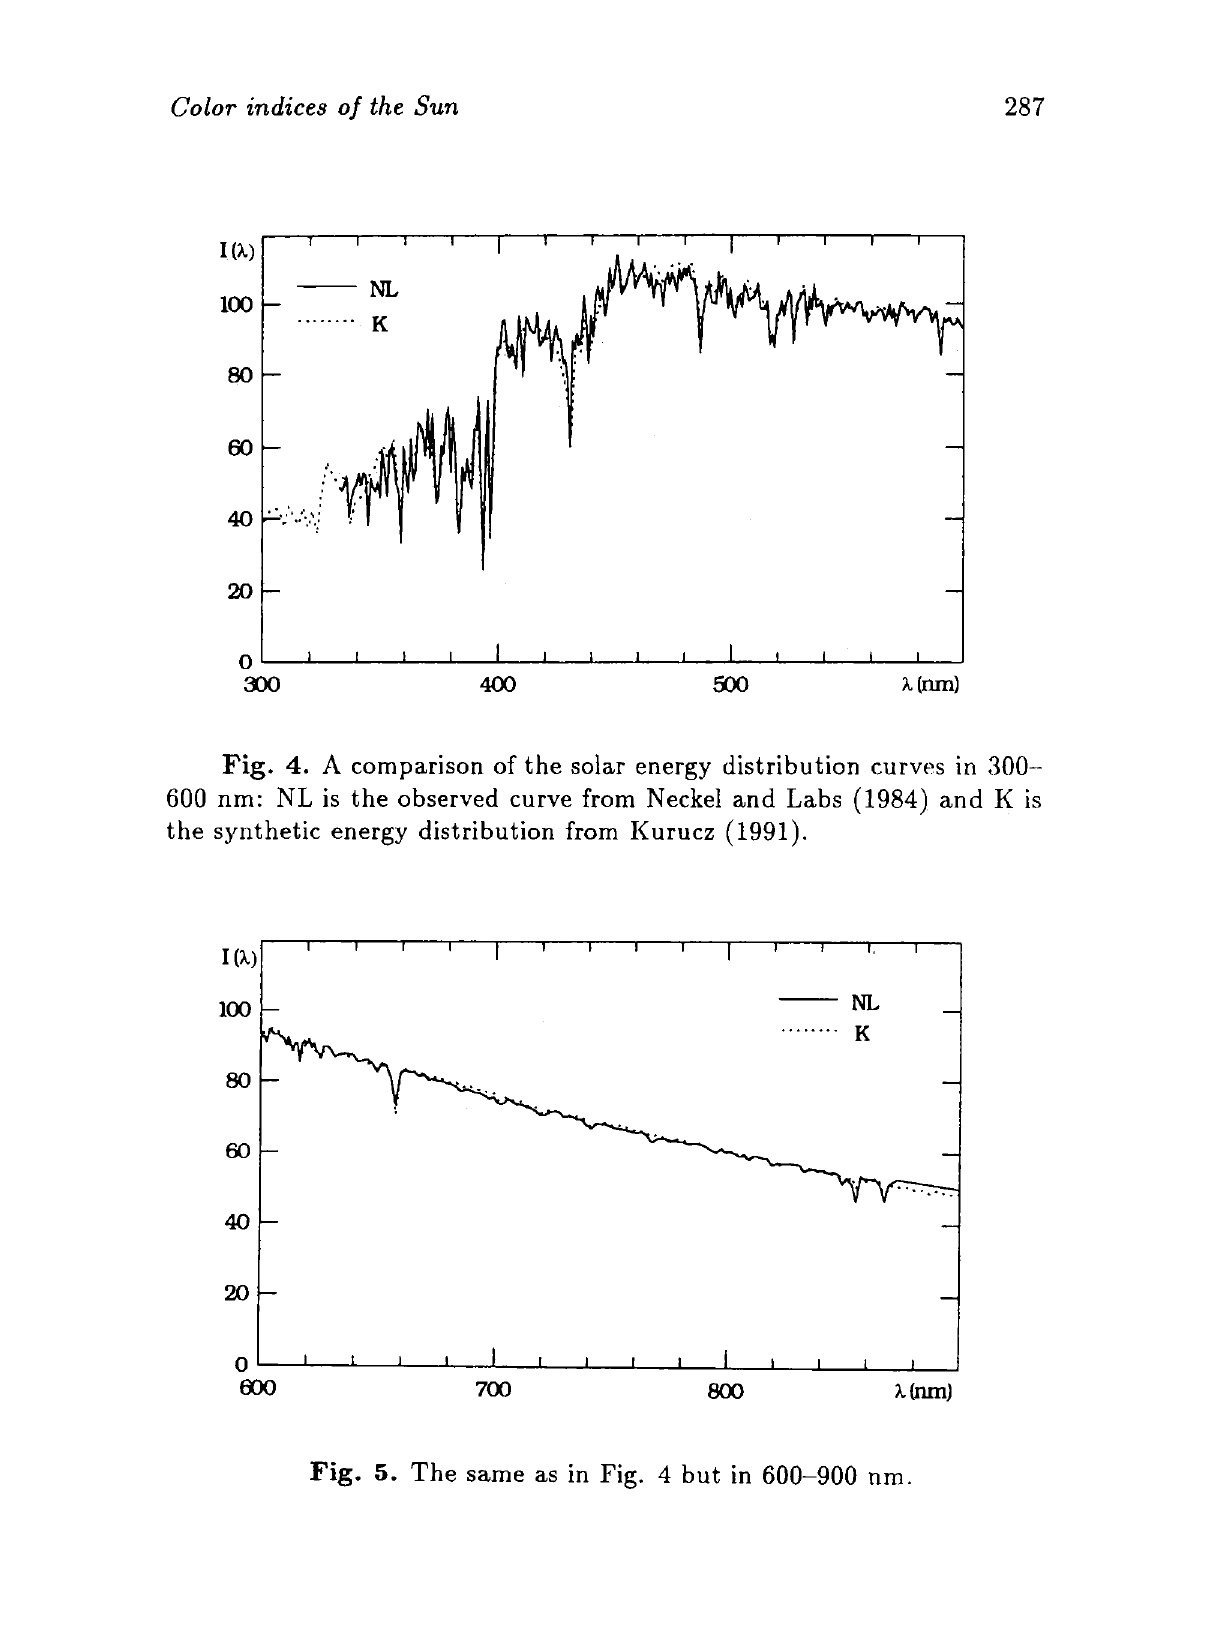
Fig. 5. The same as in Fig. 4 but in 600-900